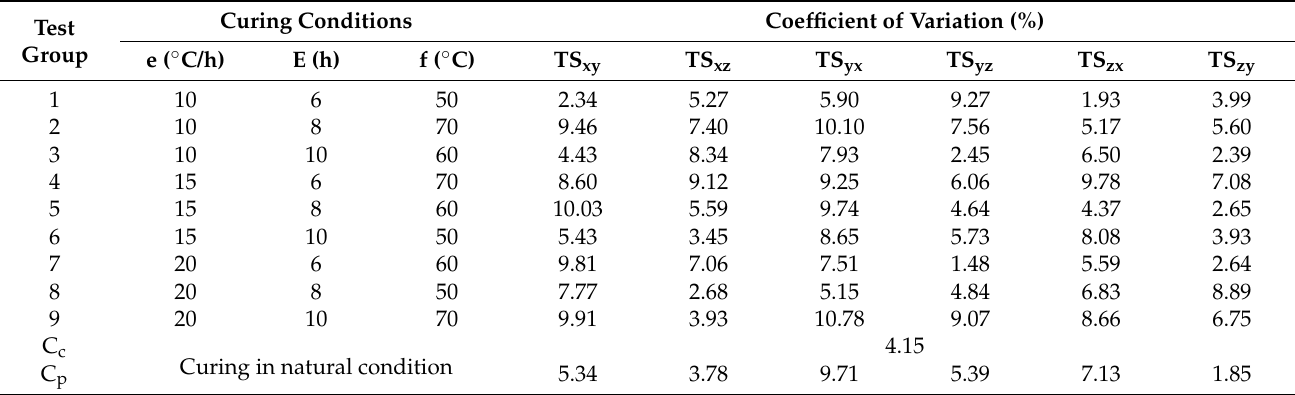
Table 7. Orthogonal experimental table of various test group designs, curing conditions, and variation coefficient of splitting tensile